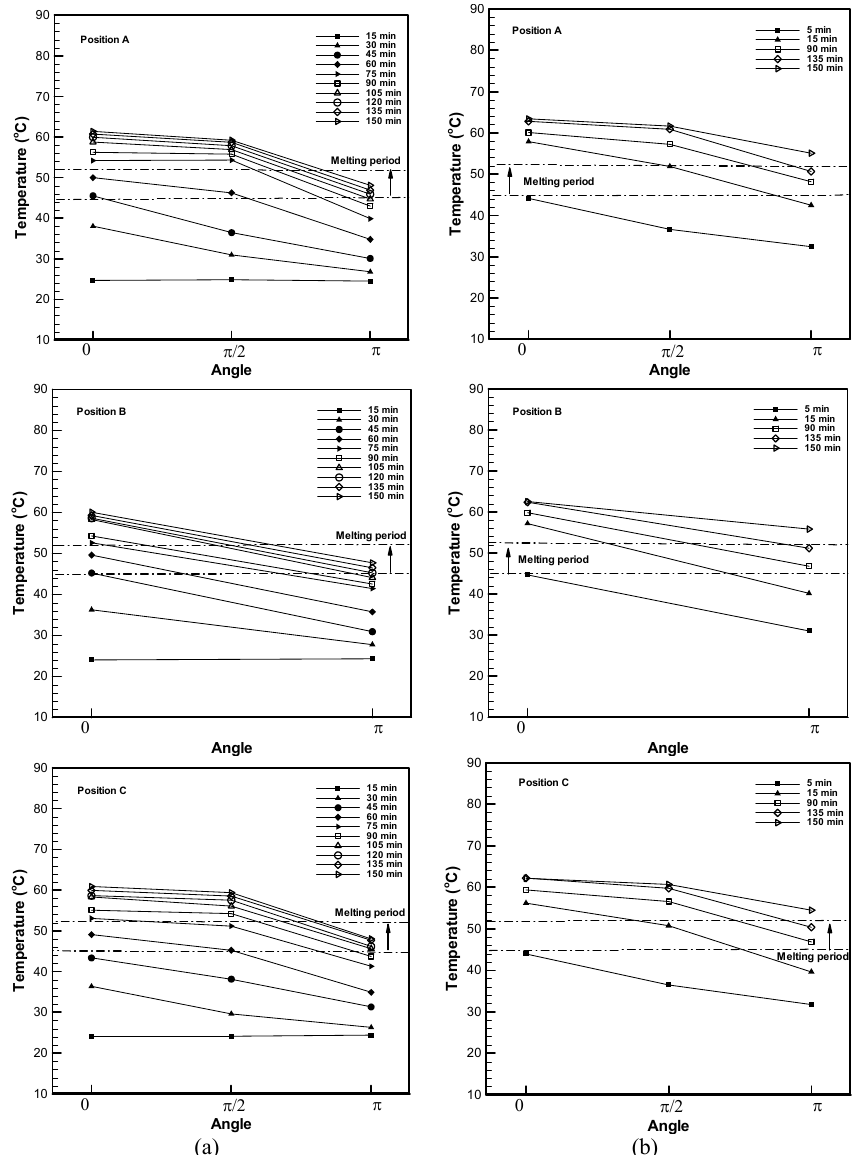
Figure 6. Experimental results of temperature distribution for 26mm height fins heat exchanger for different angles during charging process for Ste = 0.26: (a) 32.5mm radial distance and (b) 12.5mm radial distance.